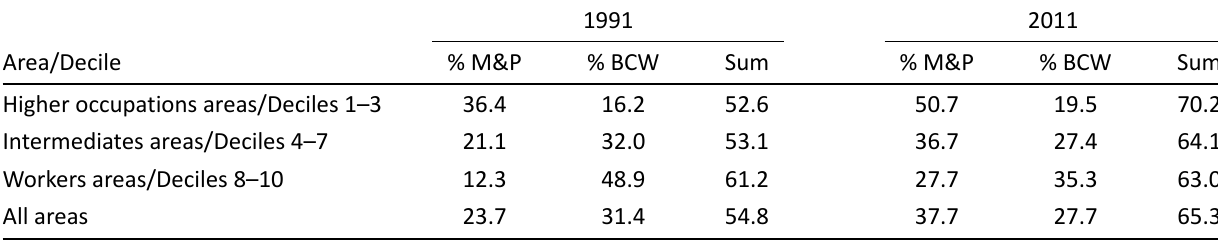
Table 2. Percentage of managers and professions (M&P) and blue-collar workers (BCW) in the active population aged 25–54 in the Athens metropolitan area, according to the percentage of blue-collar workers at the URANU